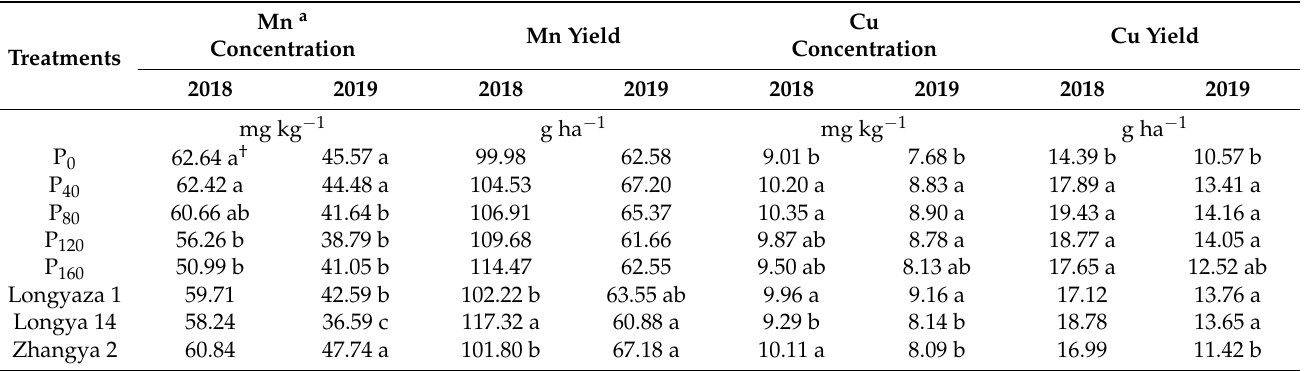
Table 6. Manganese and copper concentrations and yields for three cultivars and with five phospho- rus